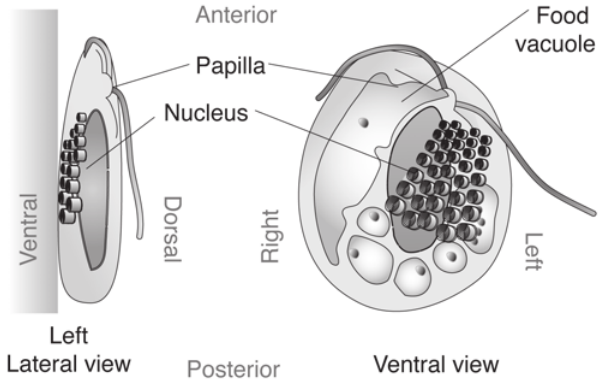
Figure 2. Diagram of cell structure of R.truncata . Left lateral view and ventral view are shown. The cell has light microscopically conspicuous ejectisomes on the ventral side. The cell glides on the surface with the ventral side down.